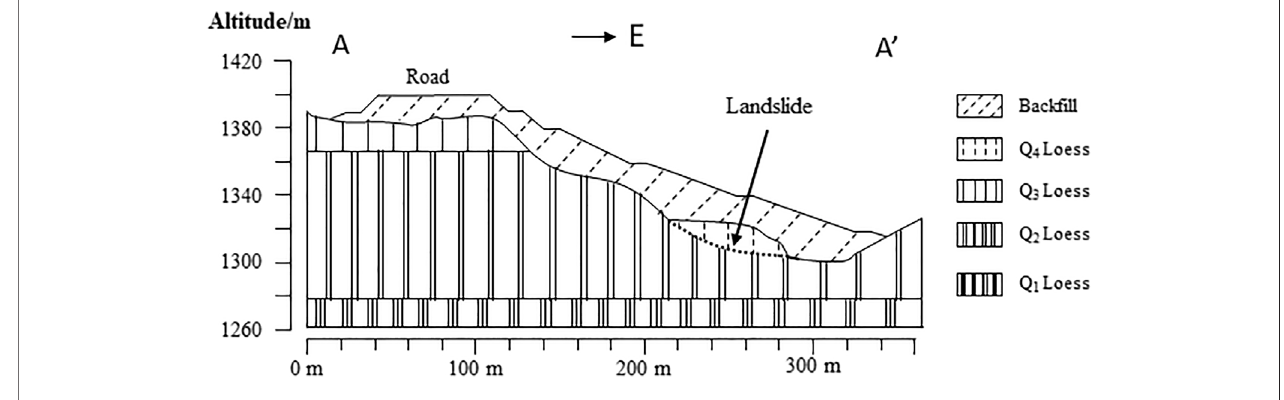
FIGURE 8 | A – A ′ pro fi le across the high back fi ll embankment.